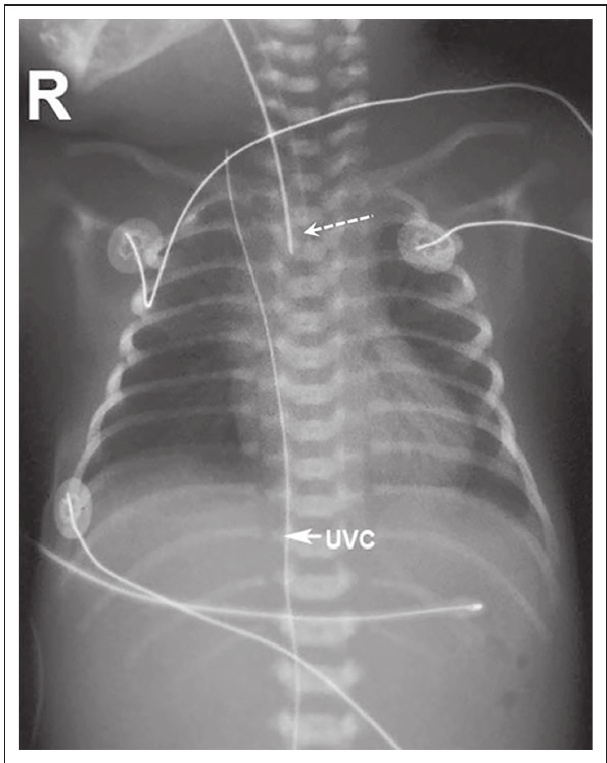
FIGURE 3: Umbilical venous catheter (UVC) advanced beyond the right atrium (RA), passing into the superior vena cava (SVC) and ending in the right internal jugular vein. Good Endotracheal tube (ETT) (dotted arrow) position.